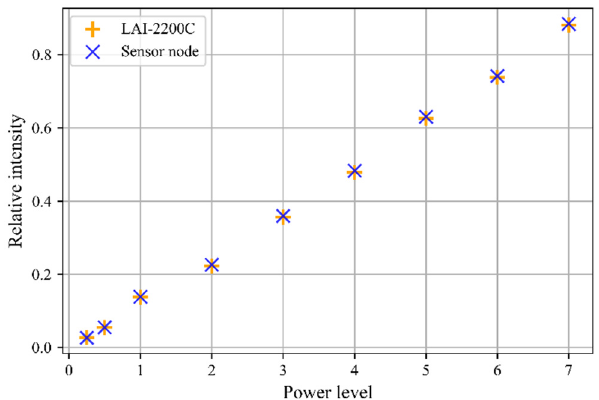
Figure 8. The relative radiation intensity that was measured by the LAI-2200C instrument and the developed sensor node as a function of the power level of the radiation